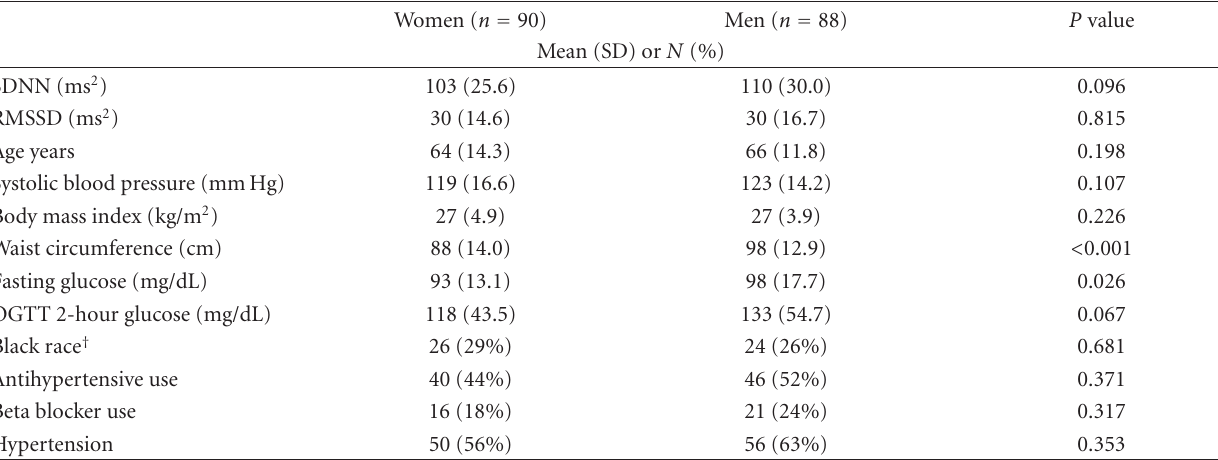
Table 1: Sample characteristics stratified by